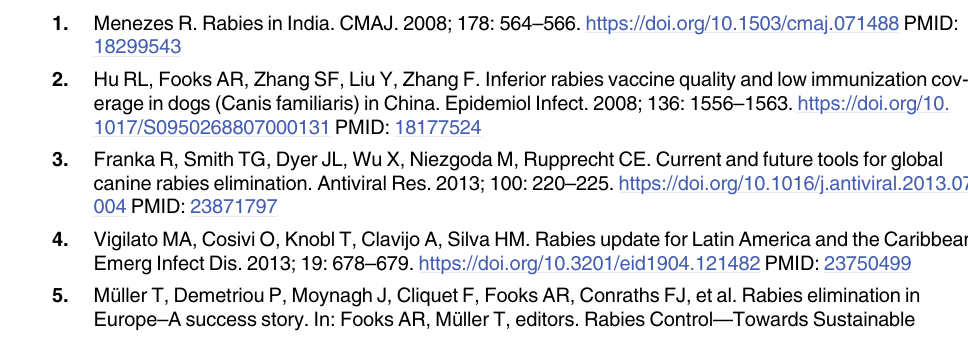
S2 Table. All data of responses to rabies challenge and rabies diagnosis in this study. S3 Table. ARRIVE guidelines